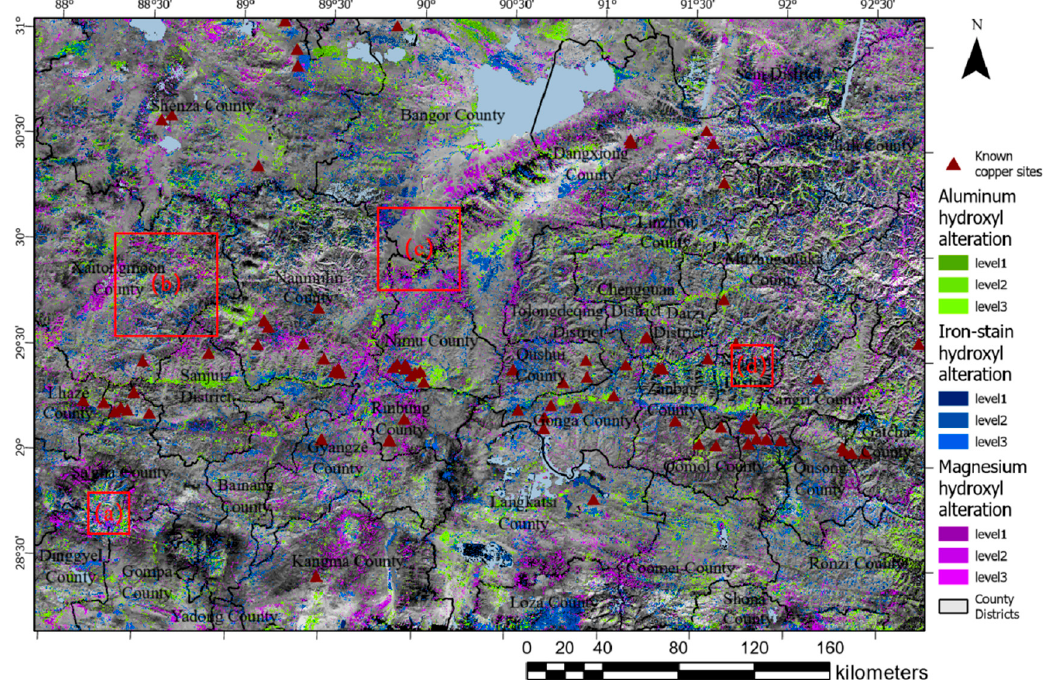
Figure 20. Distribution of erosion information on the county zoning of the study area. ( a ) Neopro- terozoic porphyry tectonic window in Saga County, Shigatse City, southwest of the study area; ( b ) Paleoproterozoic porphyry fracture zone in Xaitongmen County, Shigatse City, northwest of the study area; ( c ) Paleozoic and Paleocene granite porphyry fracture zone in the southern Tanggula Range, Nyingchi; ( d ) Paleozoic porphyry fracture zone in eastern Lhasa, central of the study area.